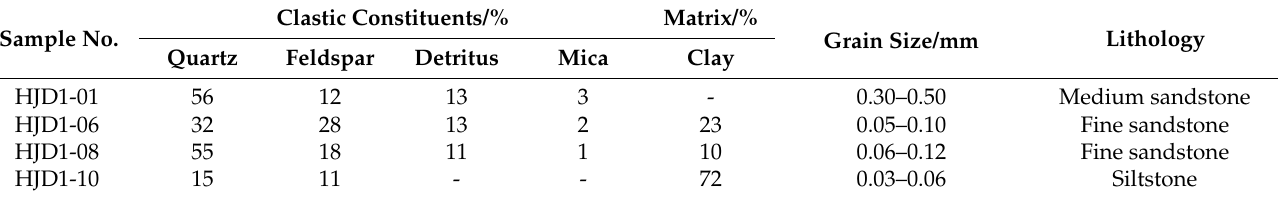
Table 1. Rock thin section identification results of sandstone samples.